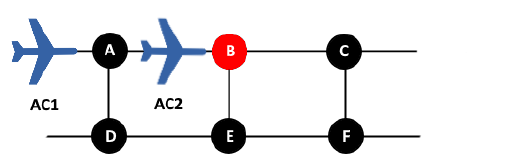
Figure 7. Aircraft Agents following each other. Node B is the conflict